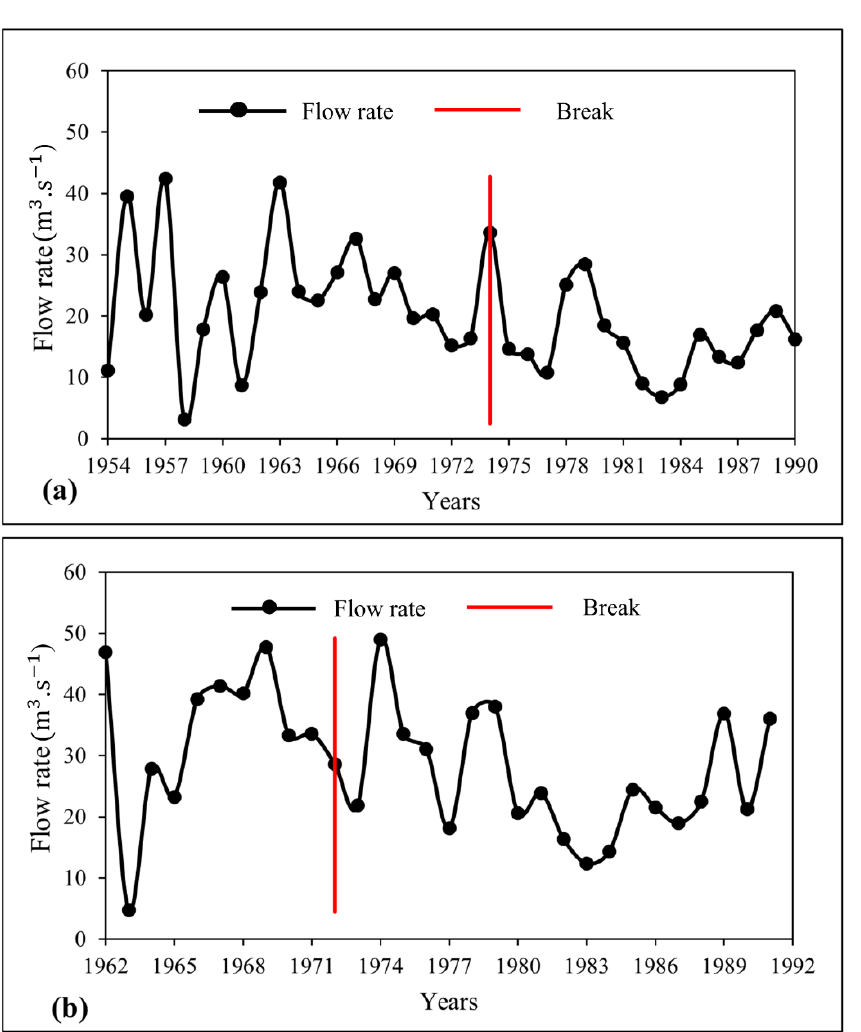
Figure 8. Interannual variation of flow at the Kara ( a ) and Kpéssidè ( b ) hydrological stations. The red line corresponds to years for which a statistical break has been computed.